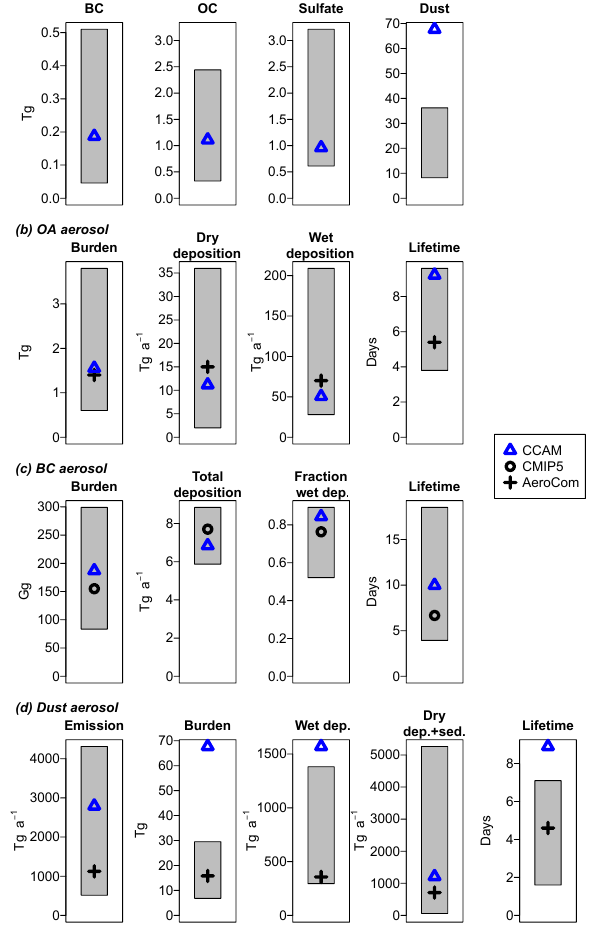
Figure 5. Comparison of present-day model results for CCAM (blue triangles) against ranges from other models (shaded gray area), for (a) global burdens of major aerosol constituents, (b) char- acteristics of OA aerosol, (c) characteristics of BC aerosol, and (d) characteristic of dust aerosol. Reference model ranges in (a) are from Kinne et al. (2006) with additional models provided from Jathar et al. (2011) for OC, Liu et al. (2005) for sulfate, and Zender et al. (2004) for dust. AeroCom Phase II model ranges and medi- ans (black crosses) in (b) are from Tsigaridis et al. (2014); CCAM modeled OC is converted to OA by multiplying by a factor of 1.4 for a consistent comparison (Tsigaridis et al., 2014). CMIP5 model ranges and medians (black circles) in (c) are from Allen and Lan- duyt (2014). AeroCom Phase I model ranges and medians (black crosses) in (d) are from Huneeus et al. (2011).